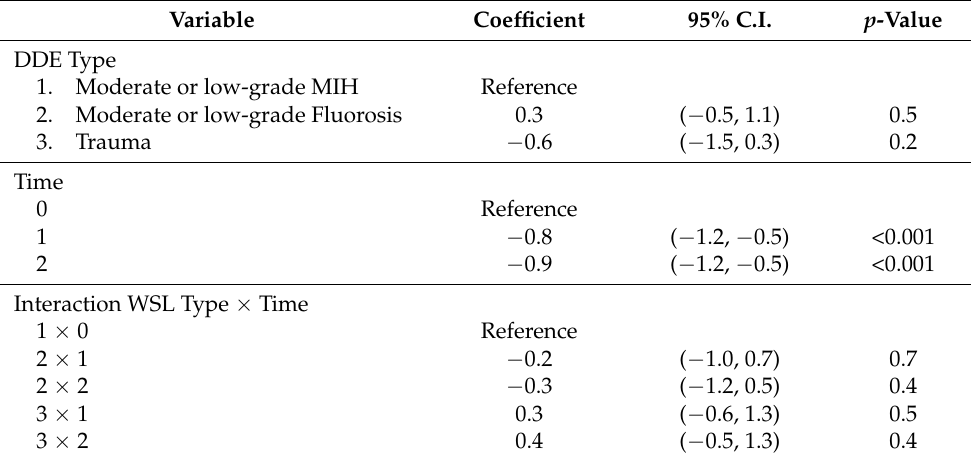
Table 5. Mixed model regression on Shiff Air